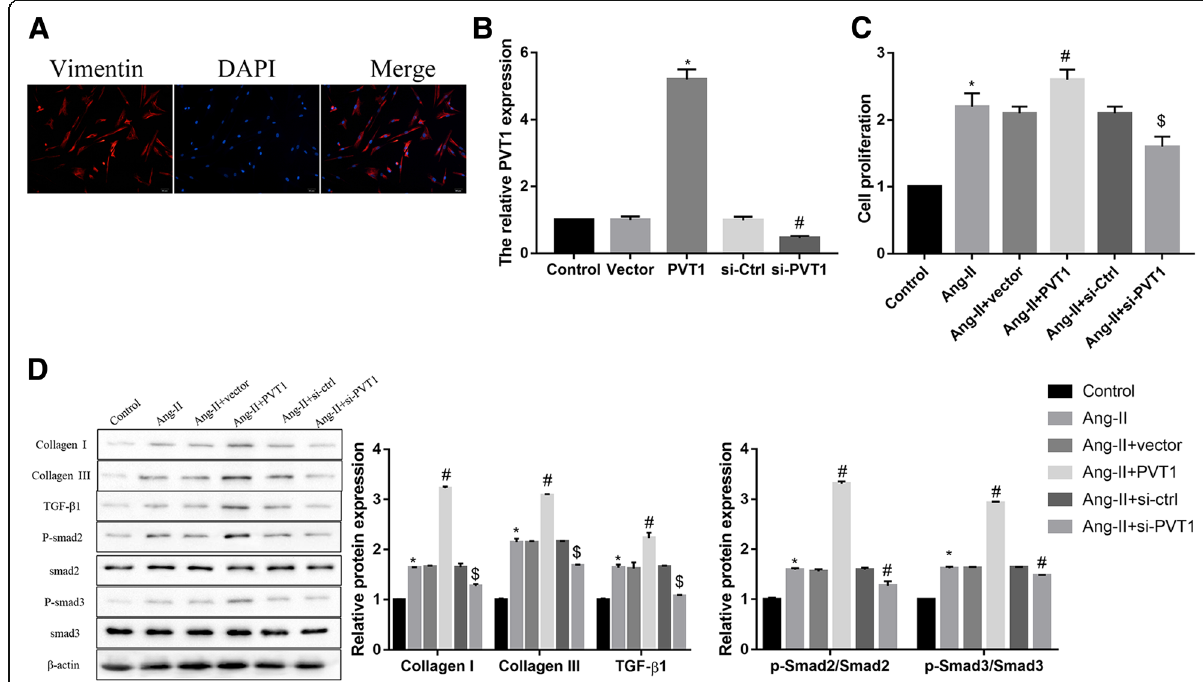
Fig. 2 Effect of PVT1 expression on Ang-II-induced fibroblasts proliferation, collagen production, and TGF- β 1/Smad signaling activation. a Identification of human atrial fibroblasts by vimentin immunostaining. Red stain is vimentin, a specific marker for fibroblasts. Blue stain is DAPI. b The overexpression and knockdown efficiency of PVT1 was confirmed by qRT-PCR. c Results of the CCK-8 assay showed that PVT1 overexpression facilitated the Ang-II-induced cell proliferation, whereas PVT1 knockdown exerted the opposite effect. d Western blot analysis showed that PVT1 overexpression further up-regulated the Ang-II-induced protein expression of Collagen I, Collagen II, TGF- β 1/Smad signaling-related proteins, whereas PVT1 knockdown exerted the opposite effect. β -actin served as the loading control. b * P < 0.05 vs. Vector, # P < 0.05 vs. si-Ctrl; c - d * P < 0.05 vs. Control, # P < 0.05 vs. Ang-II + vector, $ P < 0.05 vs. Ang-II + si-Ctrl. Data are presented as mean ± SD. PVT1, plasmacytoma